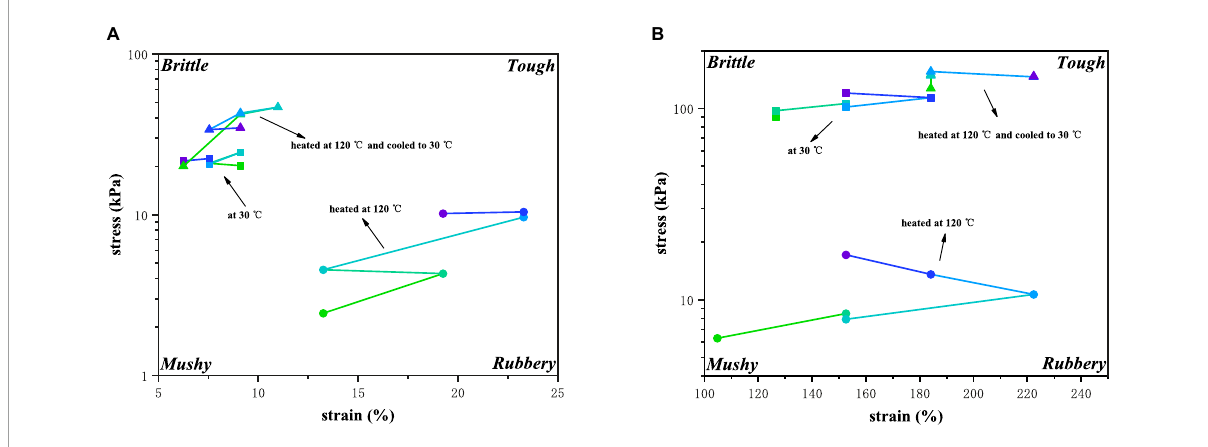
FIGURE4 Texture map for the PPI with different TG concentrations (A) at the end of the LVE regime and (B) at the crossover point.